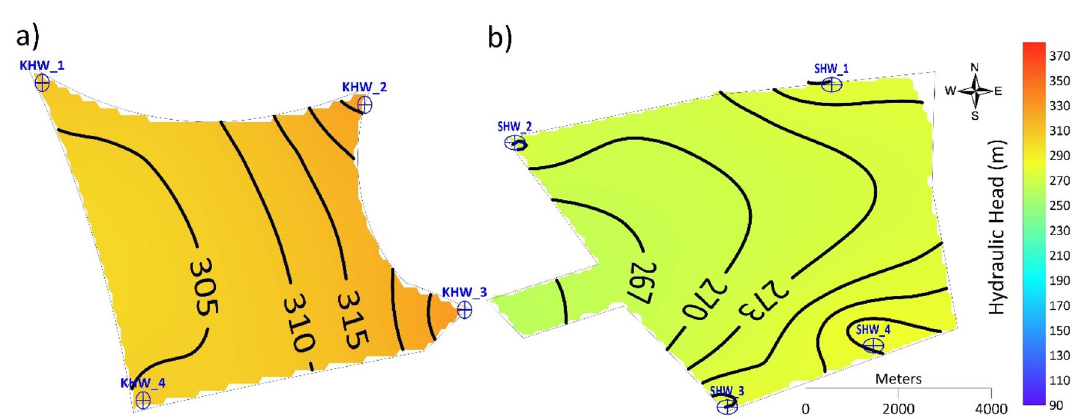
Figure 7. Simulated hydraulic head in 2030 for Scenario 1 at ( a ) Al-Khrair and ( b ) Al-Shuwaib sites.